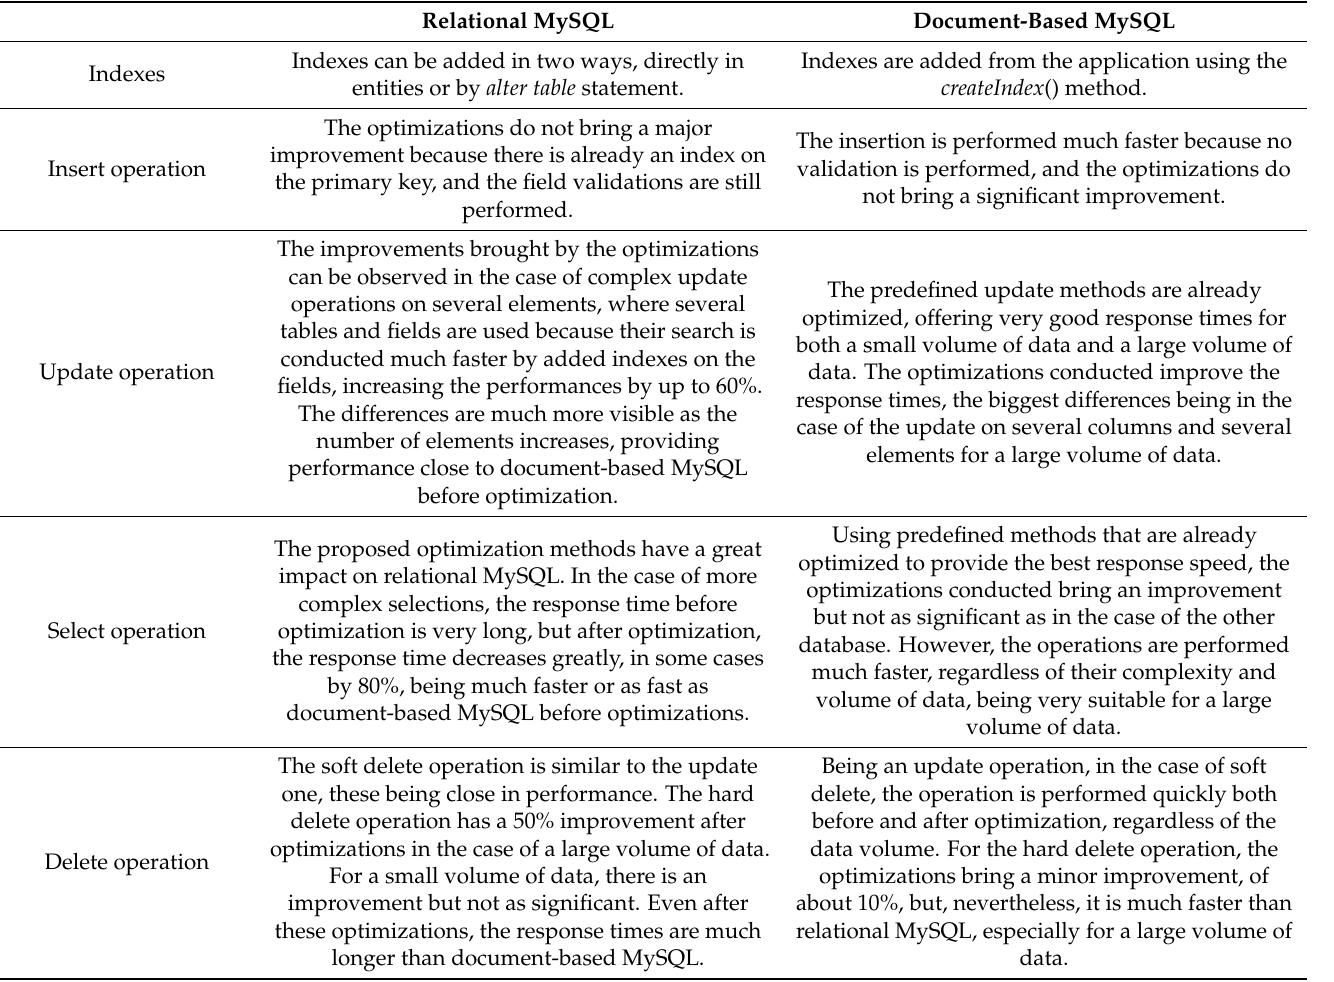
Table 15. Summary of comparative